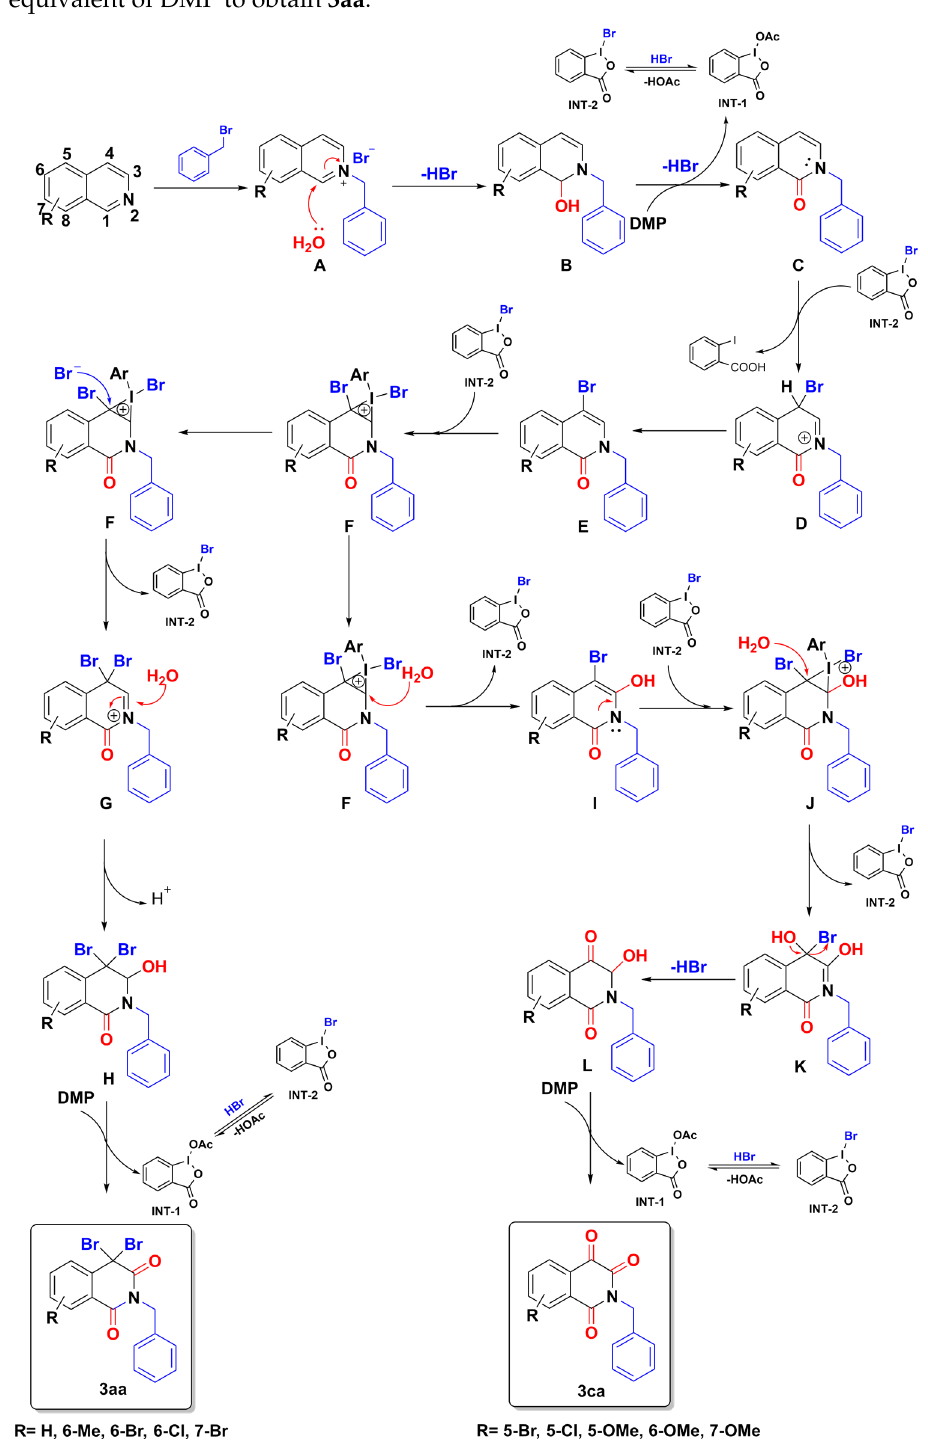
Figure 8. A plausible mechanism for the oxidative coupling reaction of isoquinoline mediated by DMP.